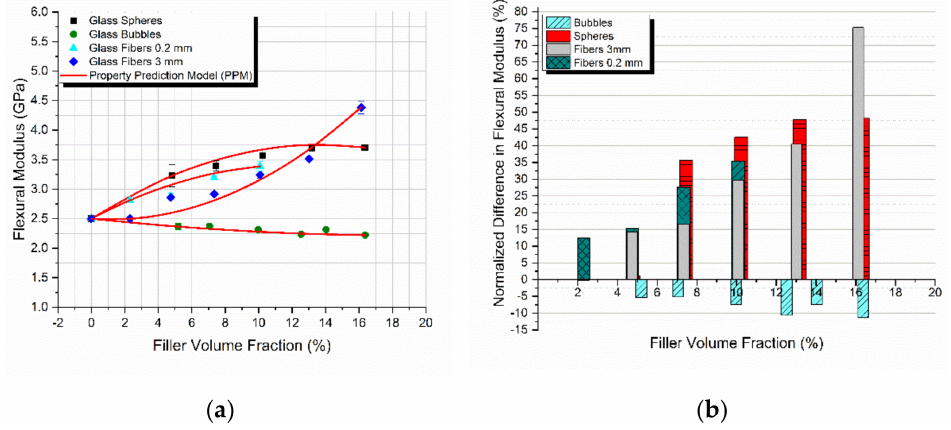
Figure 6. Comparison for all types of composites studied ( a ) between the experimental values and theoretical predictions as derived from the PPM model for the flexural modulus with the filler-volume fraction, and ( b ) the normalized modulus variation with V f relative to the